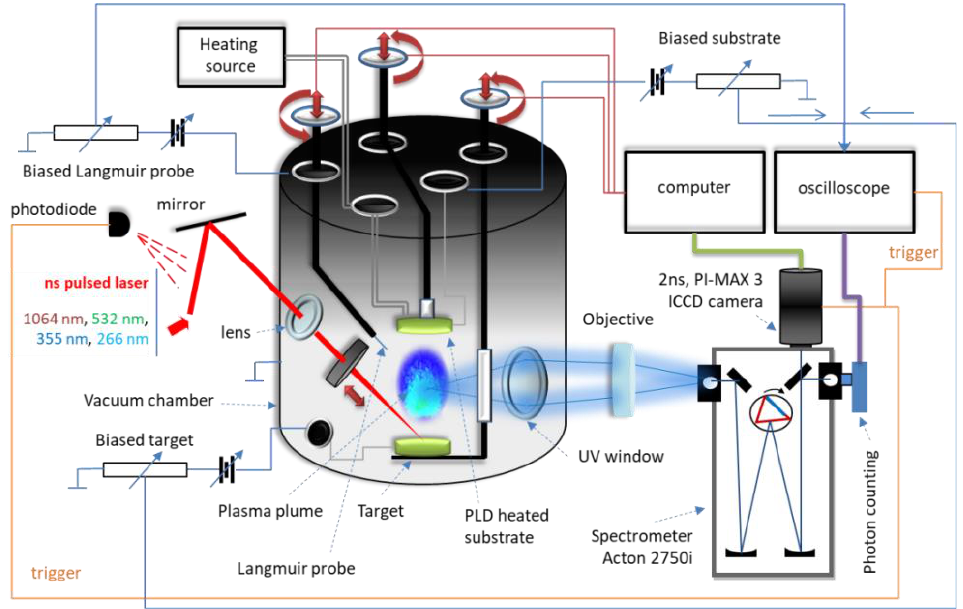
Figure 1. The experimental installation with deposition chamber.